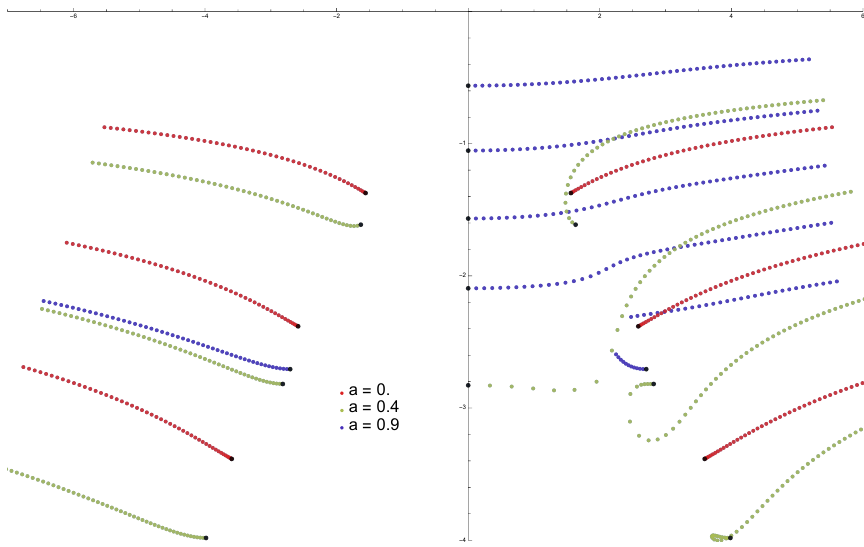
Figure 15 . Tensor QNM frequencies as in (cid:12)gure 14 but displayed in the complex frequency plane. Shown are several values of j where the black point on each curve indicates j = 0.